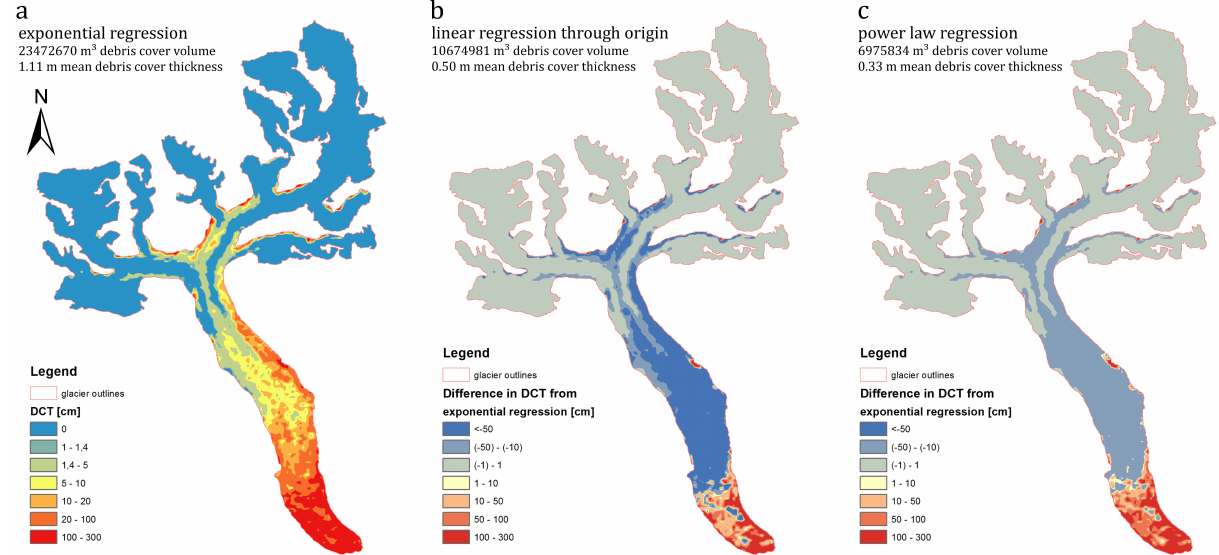
Fig. 5. (a) Debris cover thickness distribution derived from LST for the exponential regression (coefficients as in Fig. 4). (b) Difference in DCT for the linear regression through the origin relative to the exponential regression. (c) Difference in DCT for the power law regression relative to the exponential